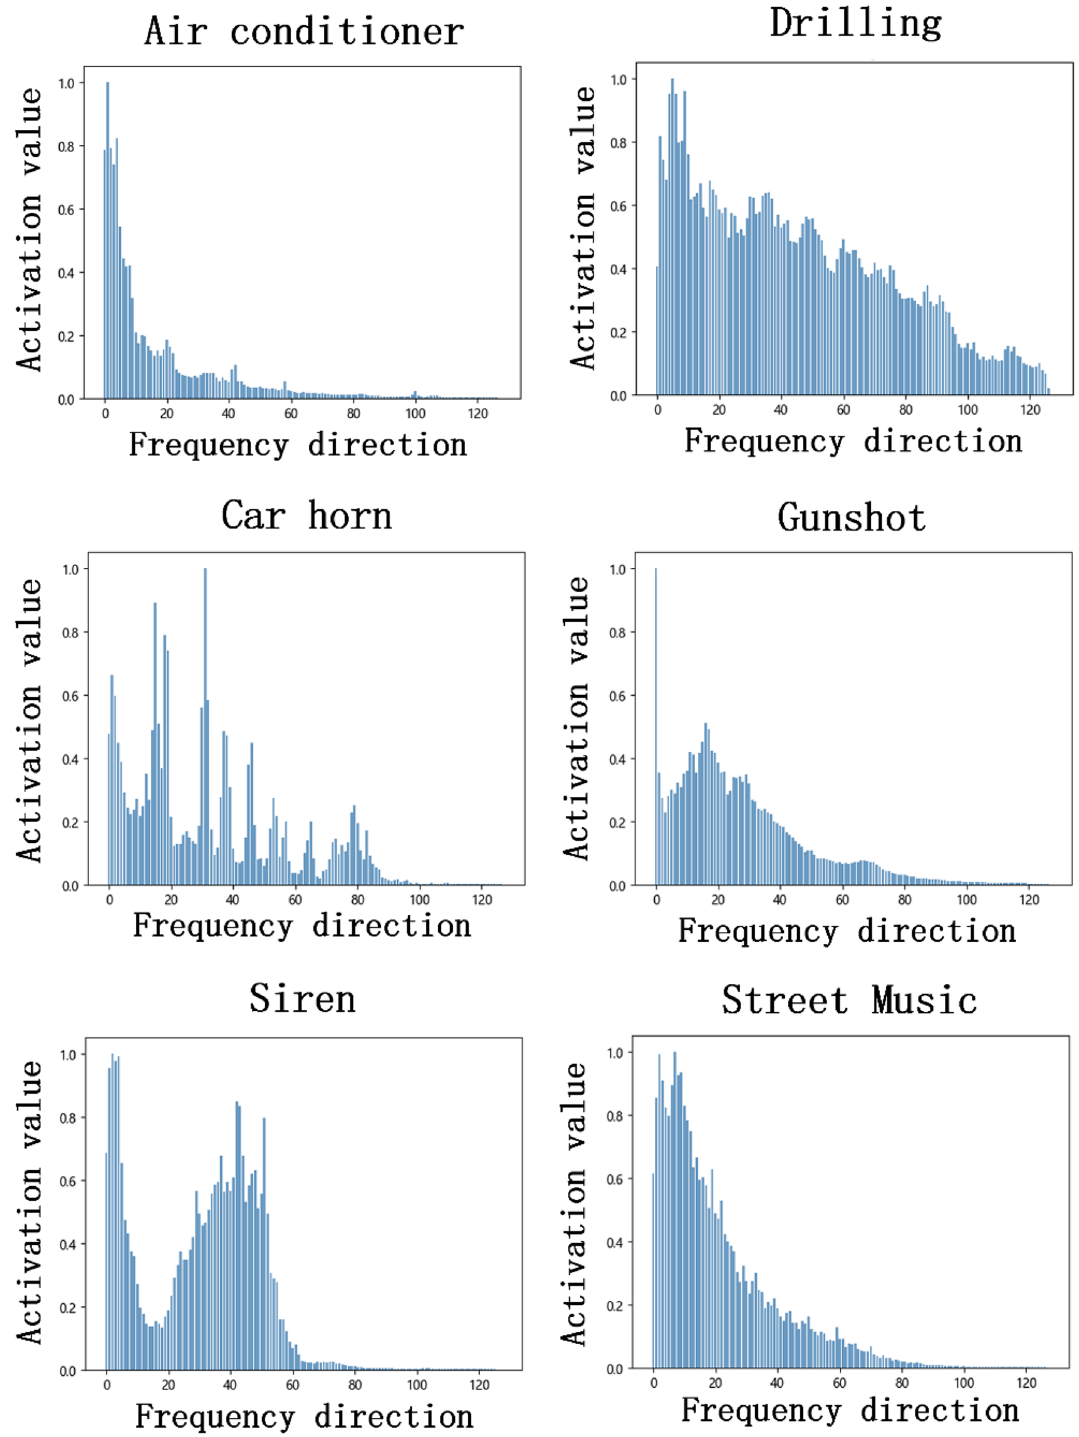
Figure 1. Frequency activation matrix for different sound